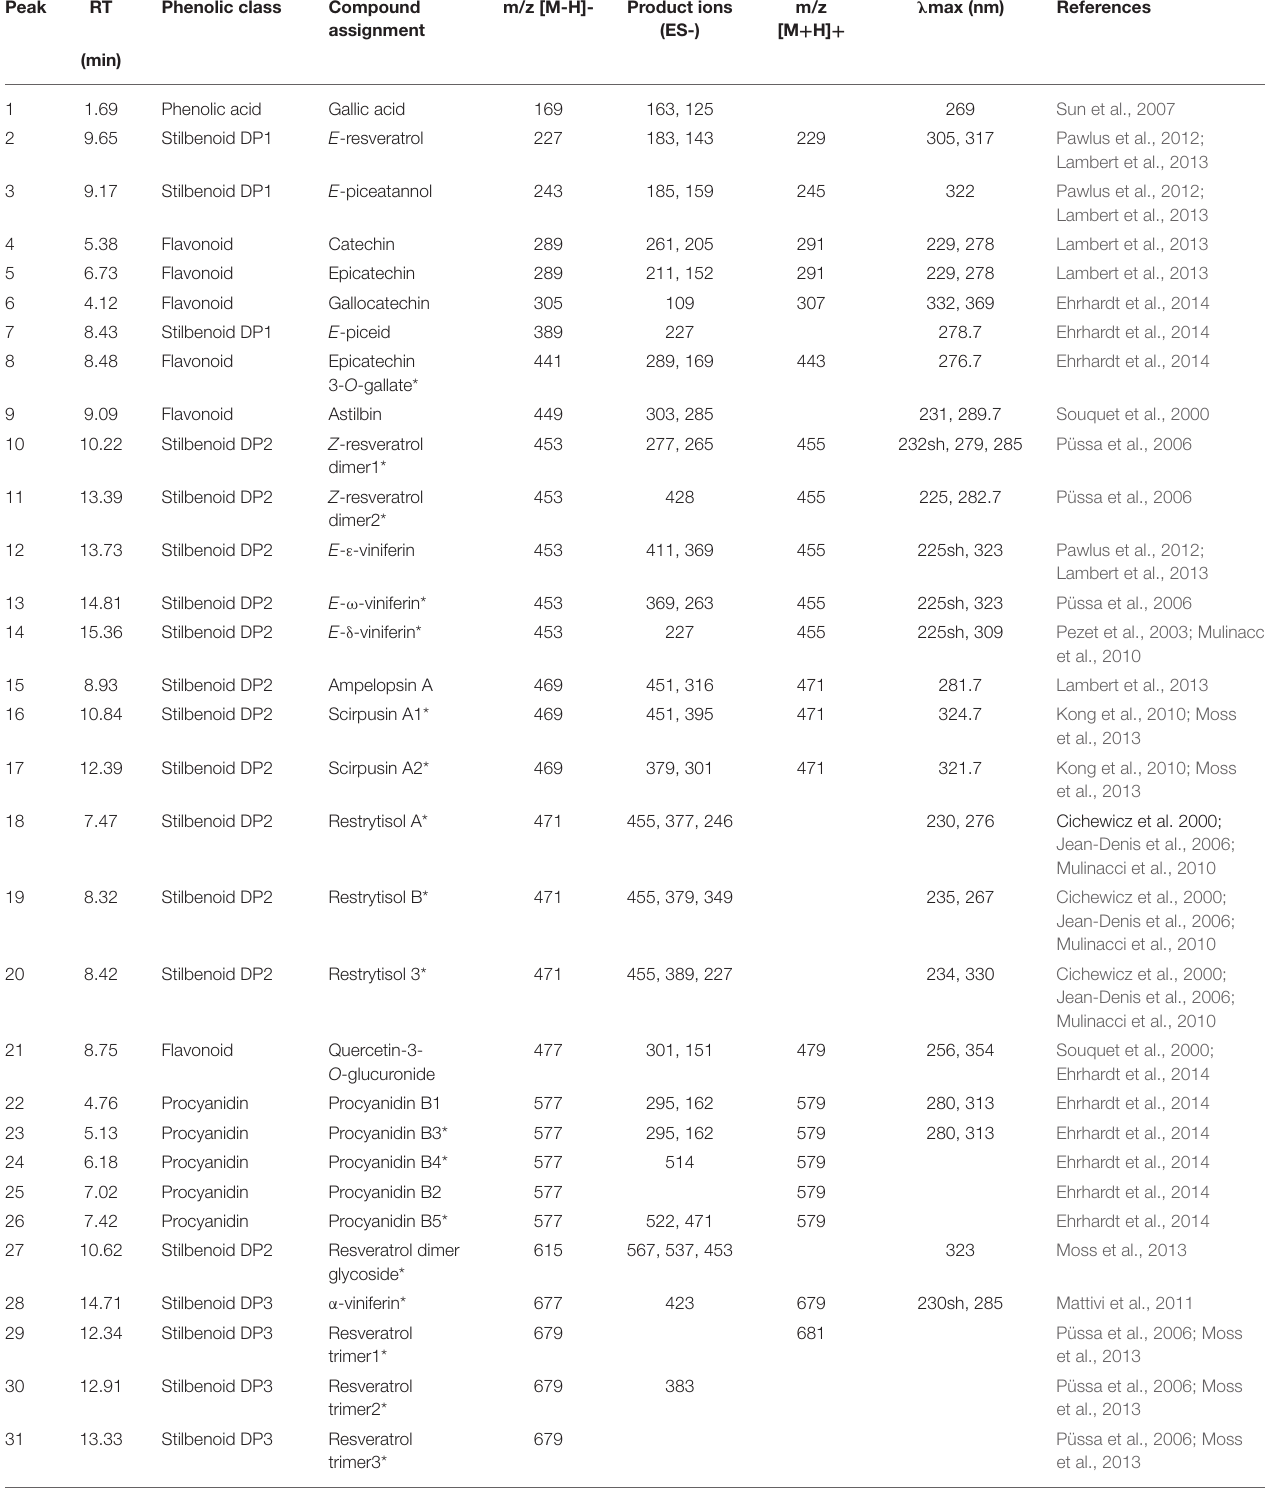
TABLE 2 | List of grape stem polyphenols identified in studied cultivars.